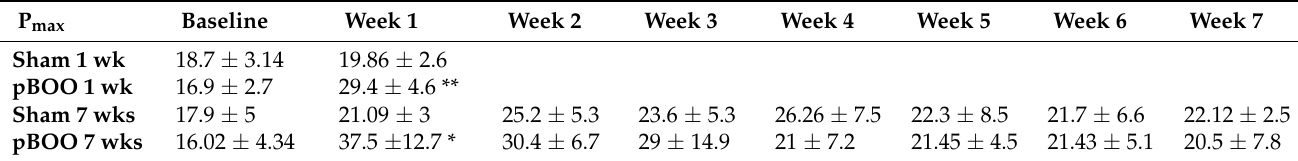
Figure 4. Functional and morphological alterations in the bladders of pBOO mice. Representative UDI recordings in sham ( A ) and pBOO at 1 week ( B ) and pBOO at 7 weeks ( C ) post-obstruction. Bladder morphology was evaluated by Masson’s trichrome staining ( D ), bladder-to-bodyweight ratio was calculated for each group ( E ). Table 2. P max in pBOO vs. sham